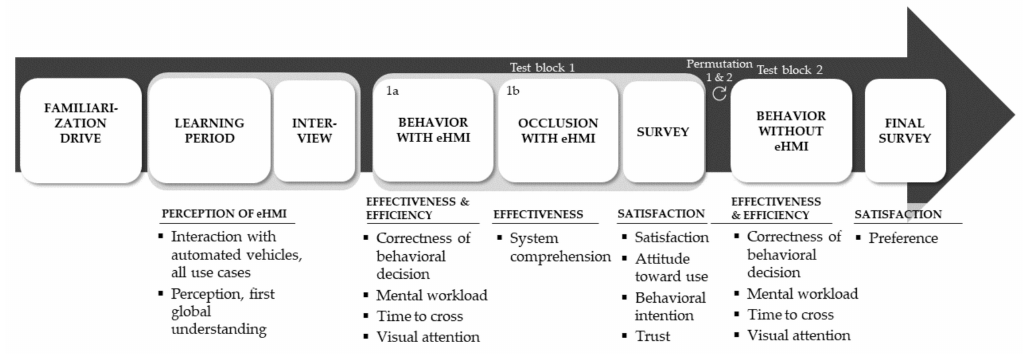
Figure 5. Procedure with measured